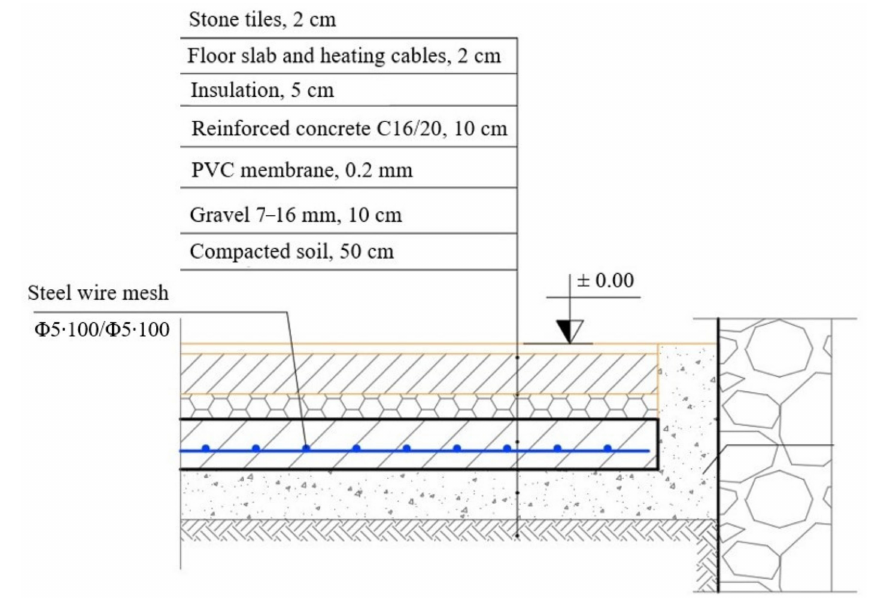
Figure 10. Floor